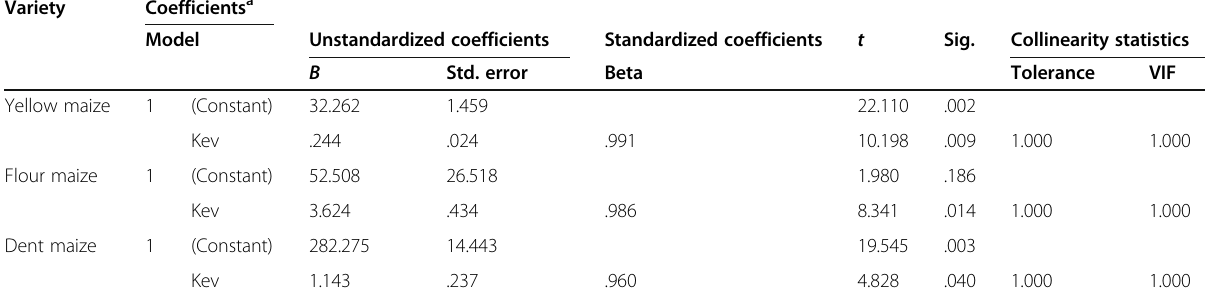
Table 4 Regression coefficients on the yellow maize, flour maize and dent maize varieties for effect of X-ray irradiation on the accumulated emergence of new progenies of S . zeamais after exposure Variety